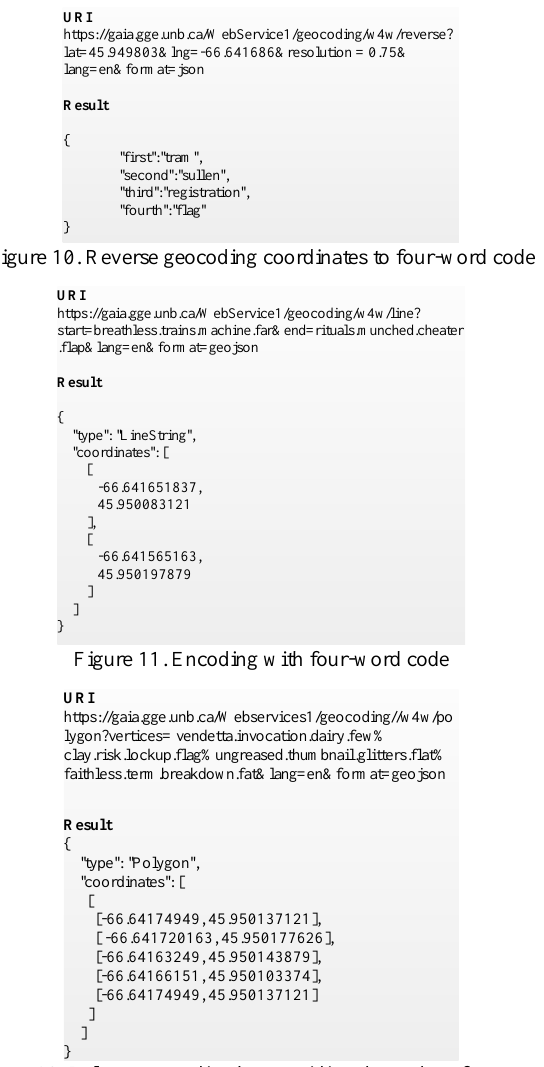
Figure 12. Polygon encoding by providing the codes of vertex